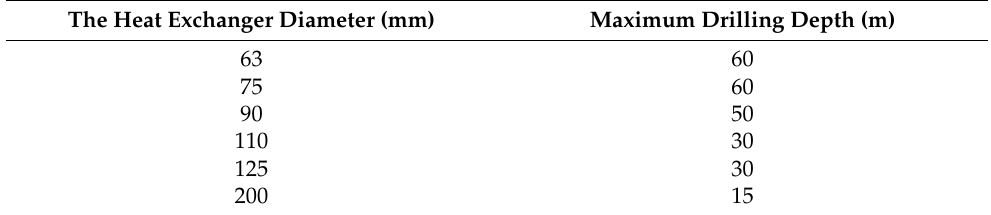
Table 3. Maximum drilling depths for different BHE diameters according to drill rig capacity [41].